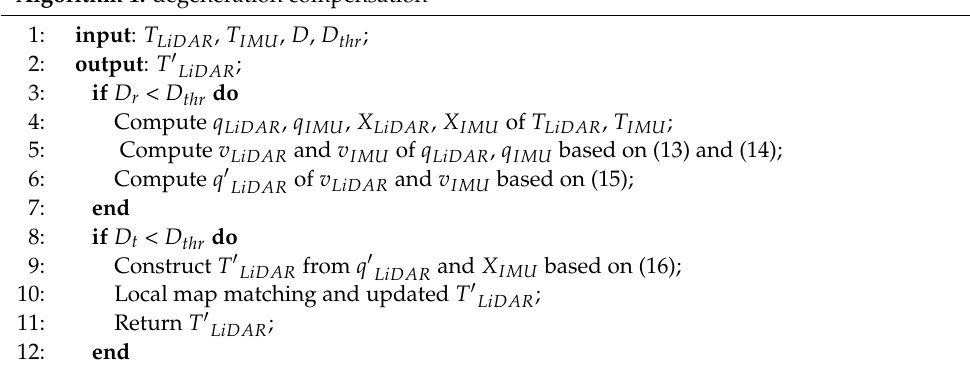
Algorithm 1. degeneration